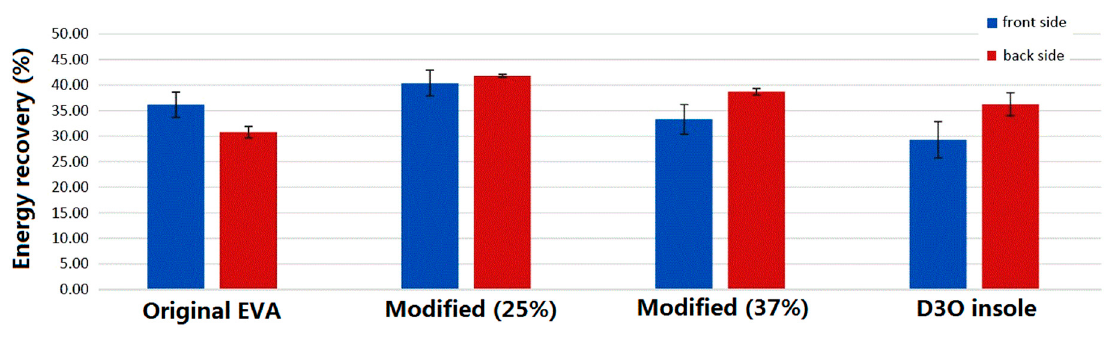
Figure 12. Comparison of energy recovery ratio (in %) in blue for forefoot area and red for heel area.